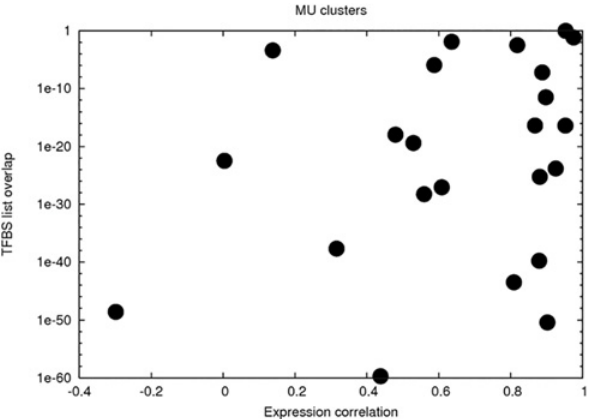
Fig 6. Relation between expression and promoter similarities. The x-axis is for Pearson correlation coefficients of average gene expression profiles of human vs mouse gene group pairs. The y-axis is for p- value of overlap of their TFBS-s